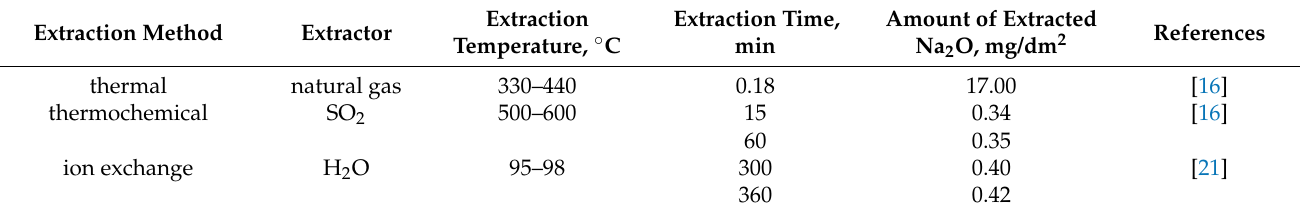
Table 2. The dependence of the amount of extracted Na 2 O on the extraction method. Extraction